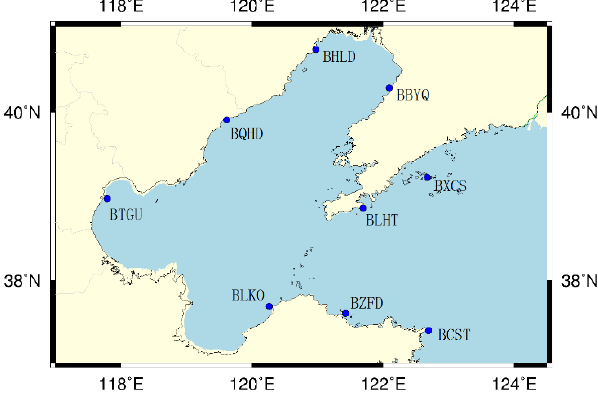
Figure 1. The co-located stations of GNSS and tide